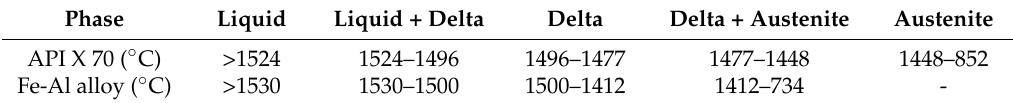
Table 2. Phase transformation temperature of API X 70.